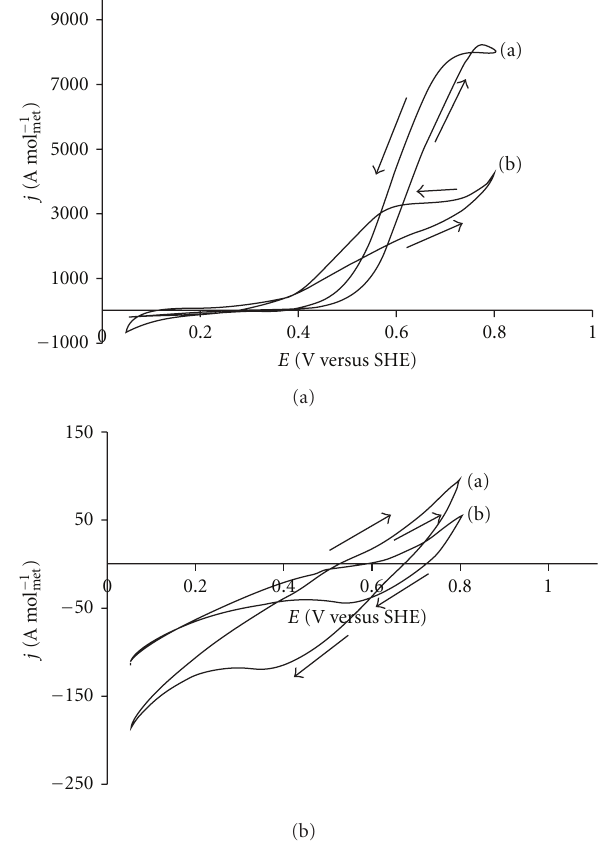
Figure 2: (a) Cyclic voltammograms of (a) methanol and (b) ethanol electro-oxidation at BDD-supported Pt 80 Ru 10 Sn 10 nano- particles. (b) Cyclic voltammograms of (c) acetaldehyde, and (d) acetic acid electro-oxidation at BDD-supported Pt 80 Ru 10 Sn 10 nano- particles. Scan rate of 20mVs − 1 in 1 M HClO 4 + 0.1 M electroactive species solutions, T = 25 ◦ C (Reprinted with permission from